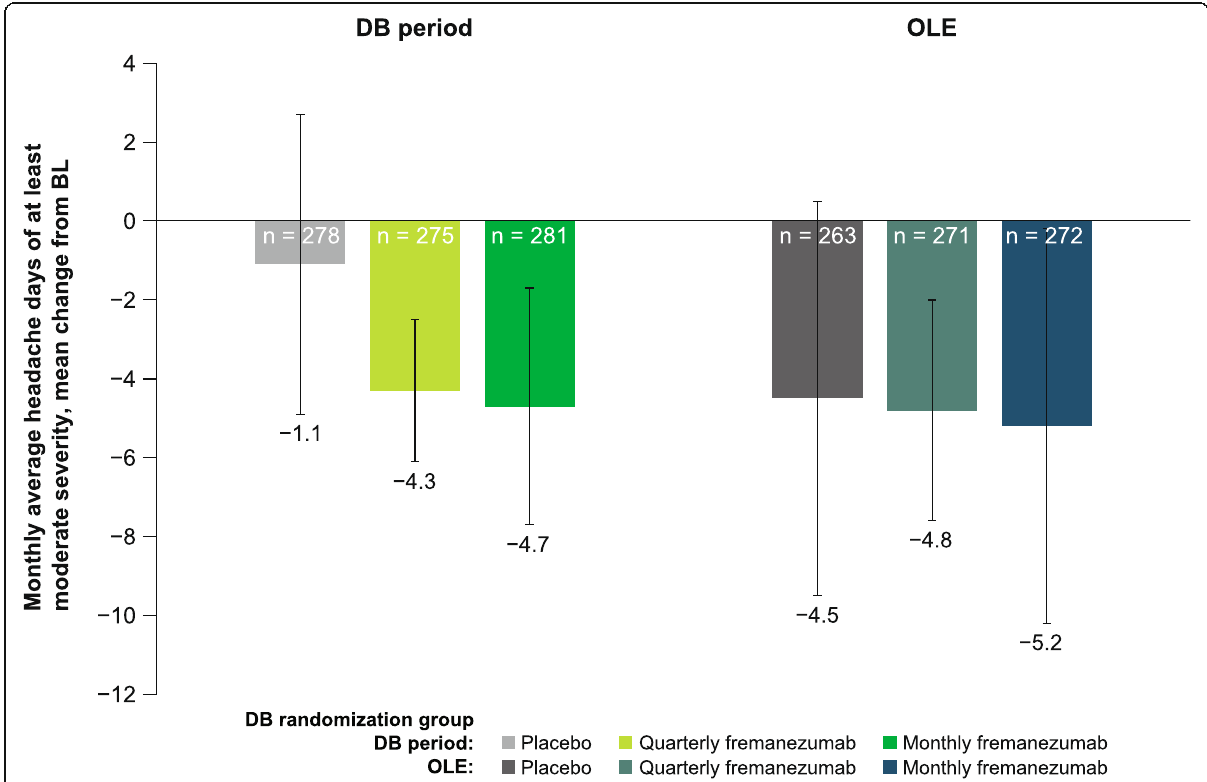
Fig. 3 Mean change from BL in the number of headache days of at least moderate severity in the DB period and the OLE (mITT). a BL, baseline; DB, double-blind; OLE, open-label extension; mITT, modified intent-to-treat. a All patients in the OLE received fremanezumab 225 mg